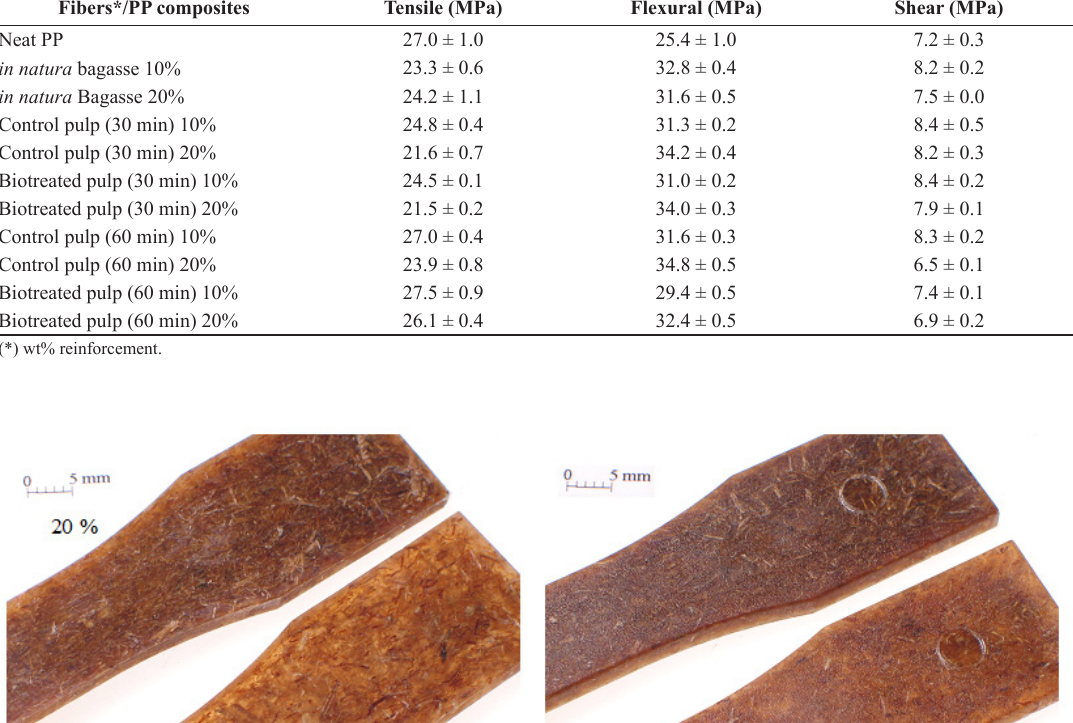
Table 3. Mechanical strength of fibers/PP composites (biotreated and control sugar cane bagasse fibers). Fibers*/PP composites